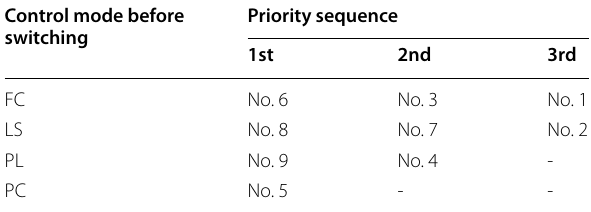
Table 2 Priority of the multi-mode controller Control mode before